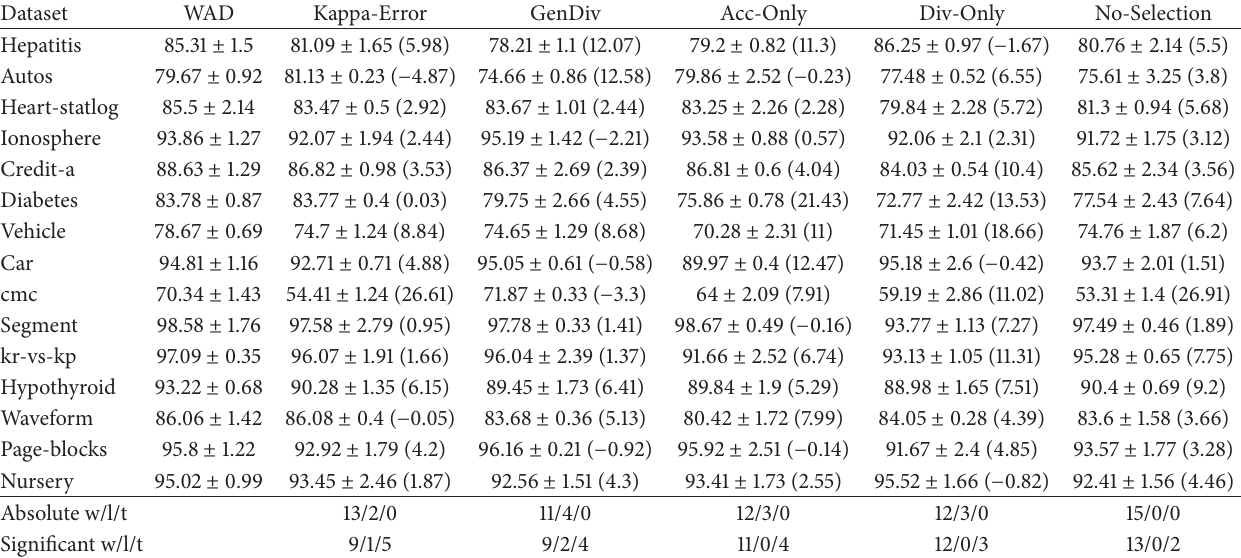
Table5:Theclassificationcorrectrate(%)ofsubensemblesselectedbycandidatemeasuresandGAusingapairwise t -testata95%significance level.